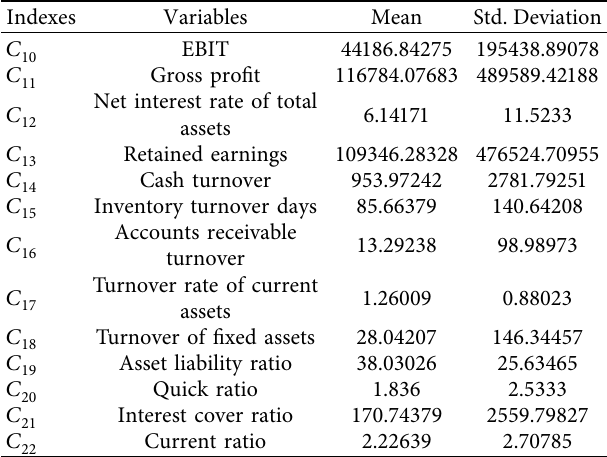
Table 3: List of independent variables for supply chain operations